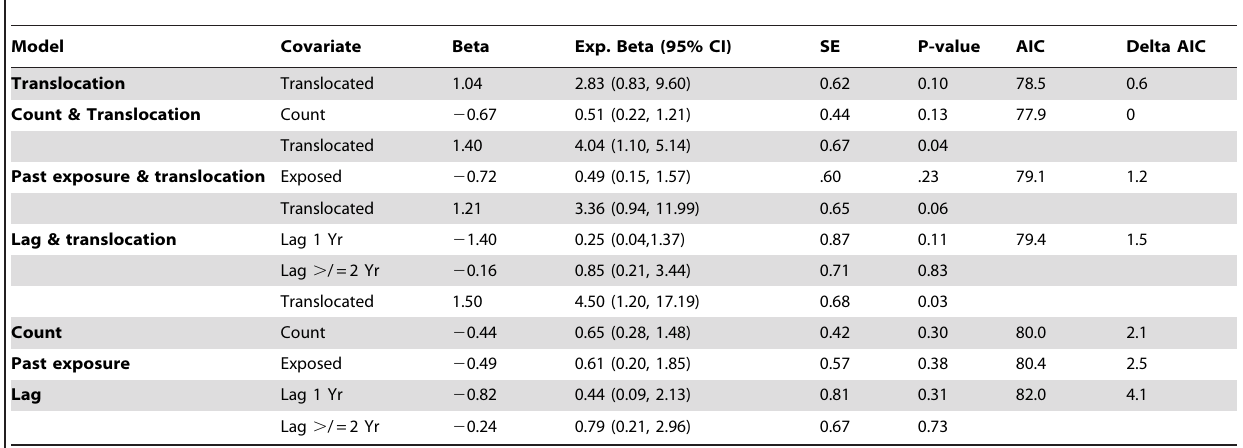
Table 5. Rams: results from Cox proportional hazards model of ram hazard of dying from pneumonia given covariates over the age-based